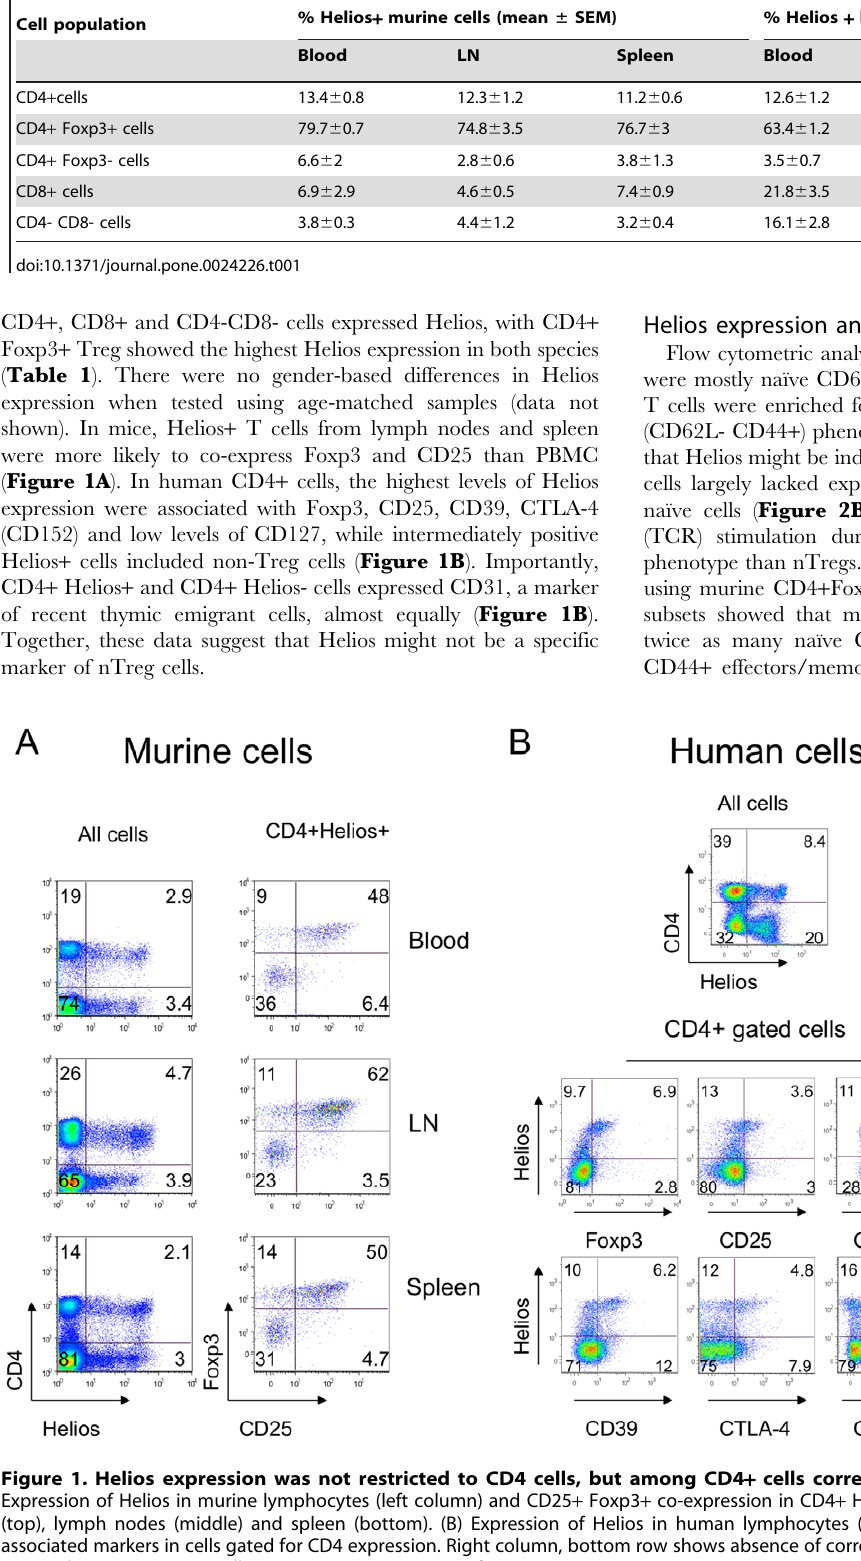
Table 1. Helios expression in mononuclear cells.